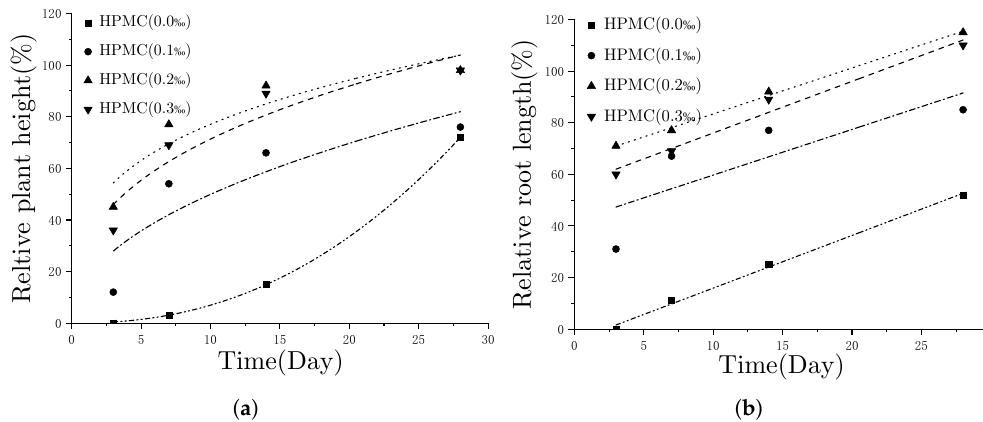
Figure 9. Curves of vegetarian development in PVC-0, PVC-1, PVC-2, and PVC-3. ( a ) Relative height of the plant versus time; ( b ) relative root length of the plant versus